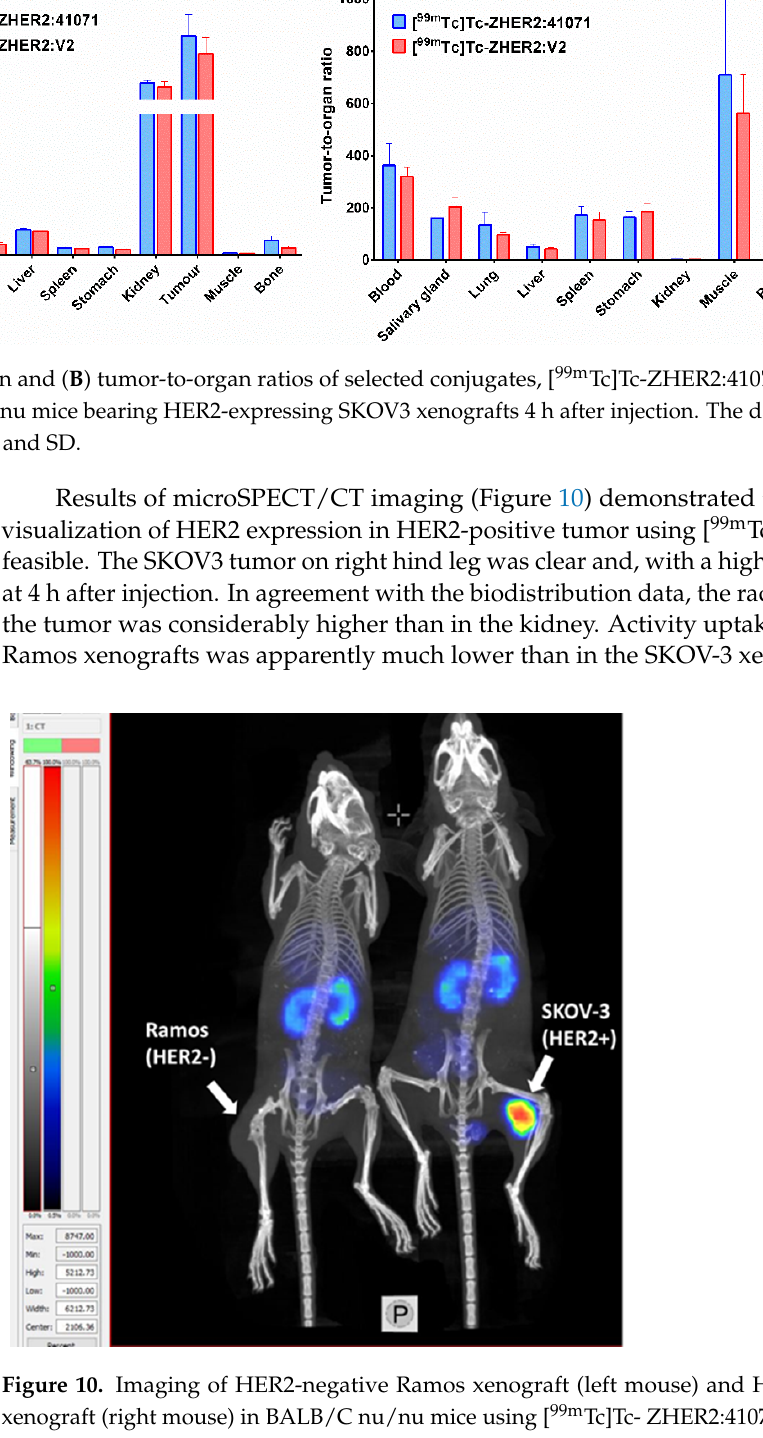
Table 5. Calculated absorbed dose (mGy/MBq) for [ 99m Tc]Tc-ZHER2:41071 in humans using OLINDA/EXM 1.0.